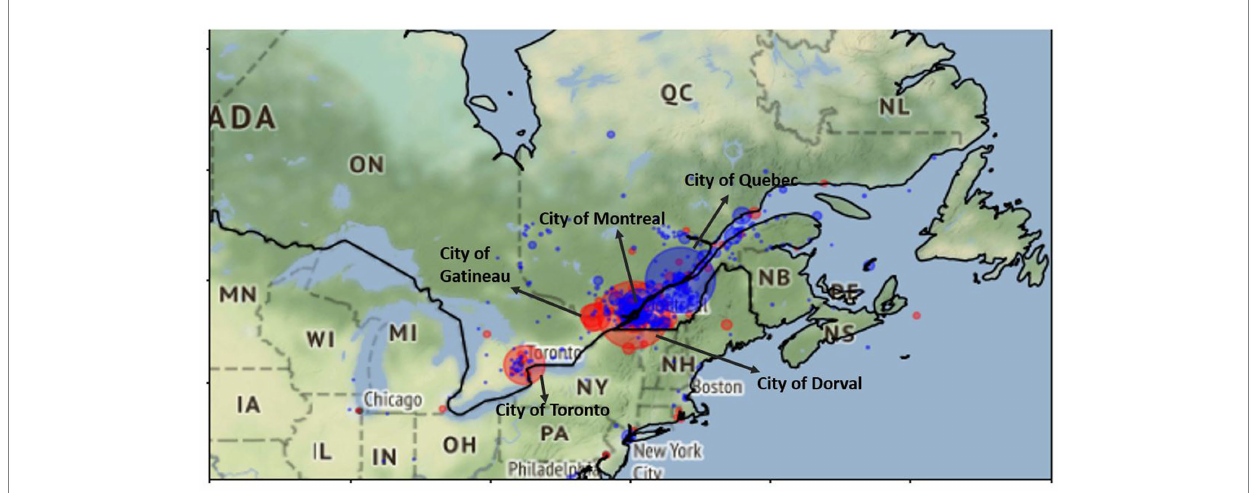
FIGURE 4 +/ − Differential distribution of +CS-Engl. (red) und –CS-Engl. (blue) in French Tweets in Quebec and Ontario. City of Dorval is the most prominent city for +CS-Engl. in French tweets, followed by Toronto and the city of Gatineau. Base map and data from OpenStreetMap and OpenStreetMap Foundation under the Open Database License.